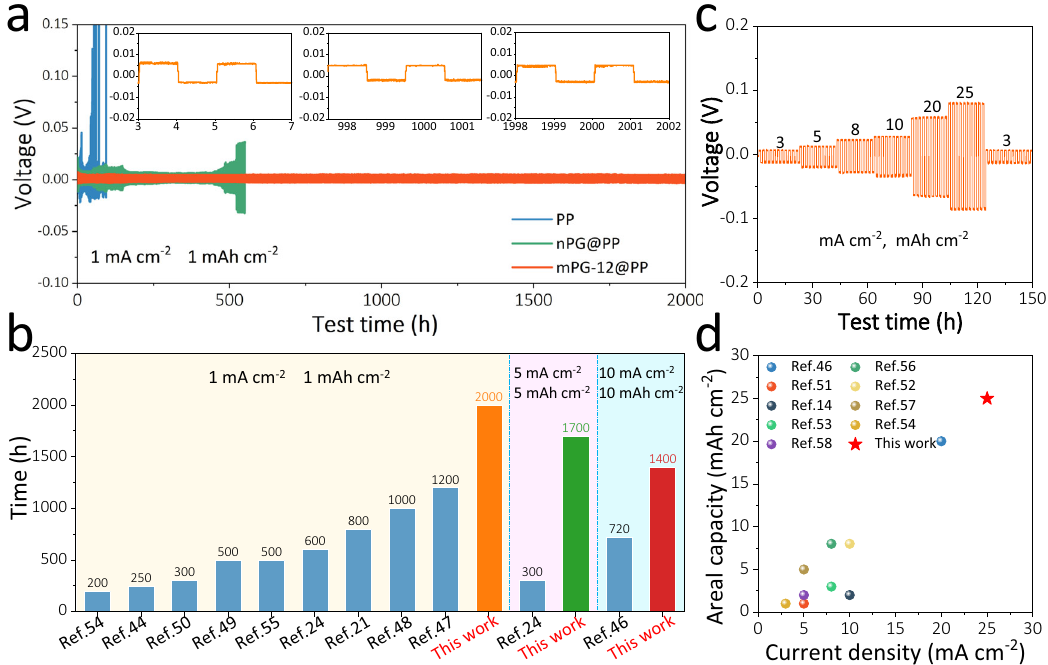
Fig. 5 Electrochemical characterization of mPG-12@PP separator for Na || Na symmetric cells. a Voltage – time pro fi les of Na || Na cells with mPG-12@PP, nPG@PP, and PP separators at 1 mA cm – 2 , 1 mAh cm – 2 (insets: magni fi ed voltage pro fi les of Na || Na cell with mPG-12@PP at 5, 1000, and 2000 h, respectively). b Cycling stability comparison of Na || Na cells with mPG-12@PP separator and those of previously reported Na anodes stabilized by various methods at the same current densities and capacity. c Rate performance of Na || Na cells with mPG-12@PP separator obtained at different current densities and capacity, respectively. d Rate performance comparison of Na || Na cells with mPG-12@PP separator and other reported works